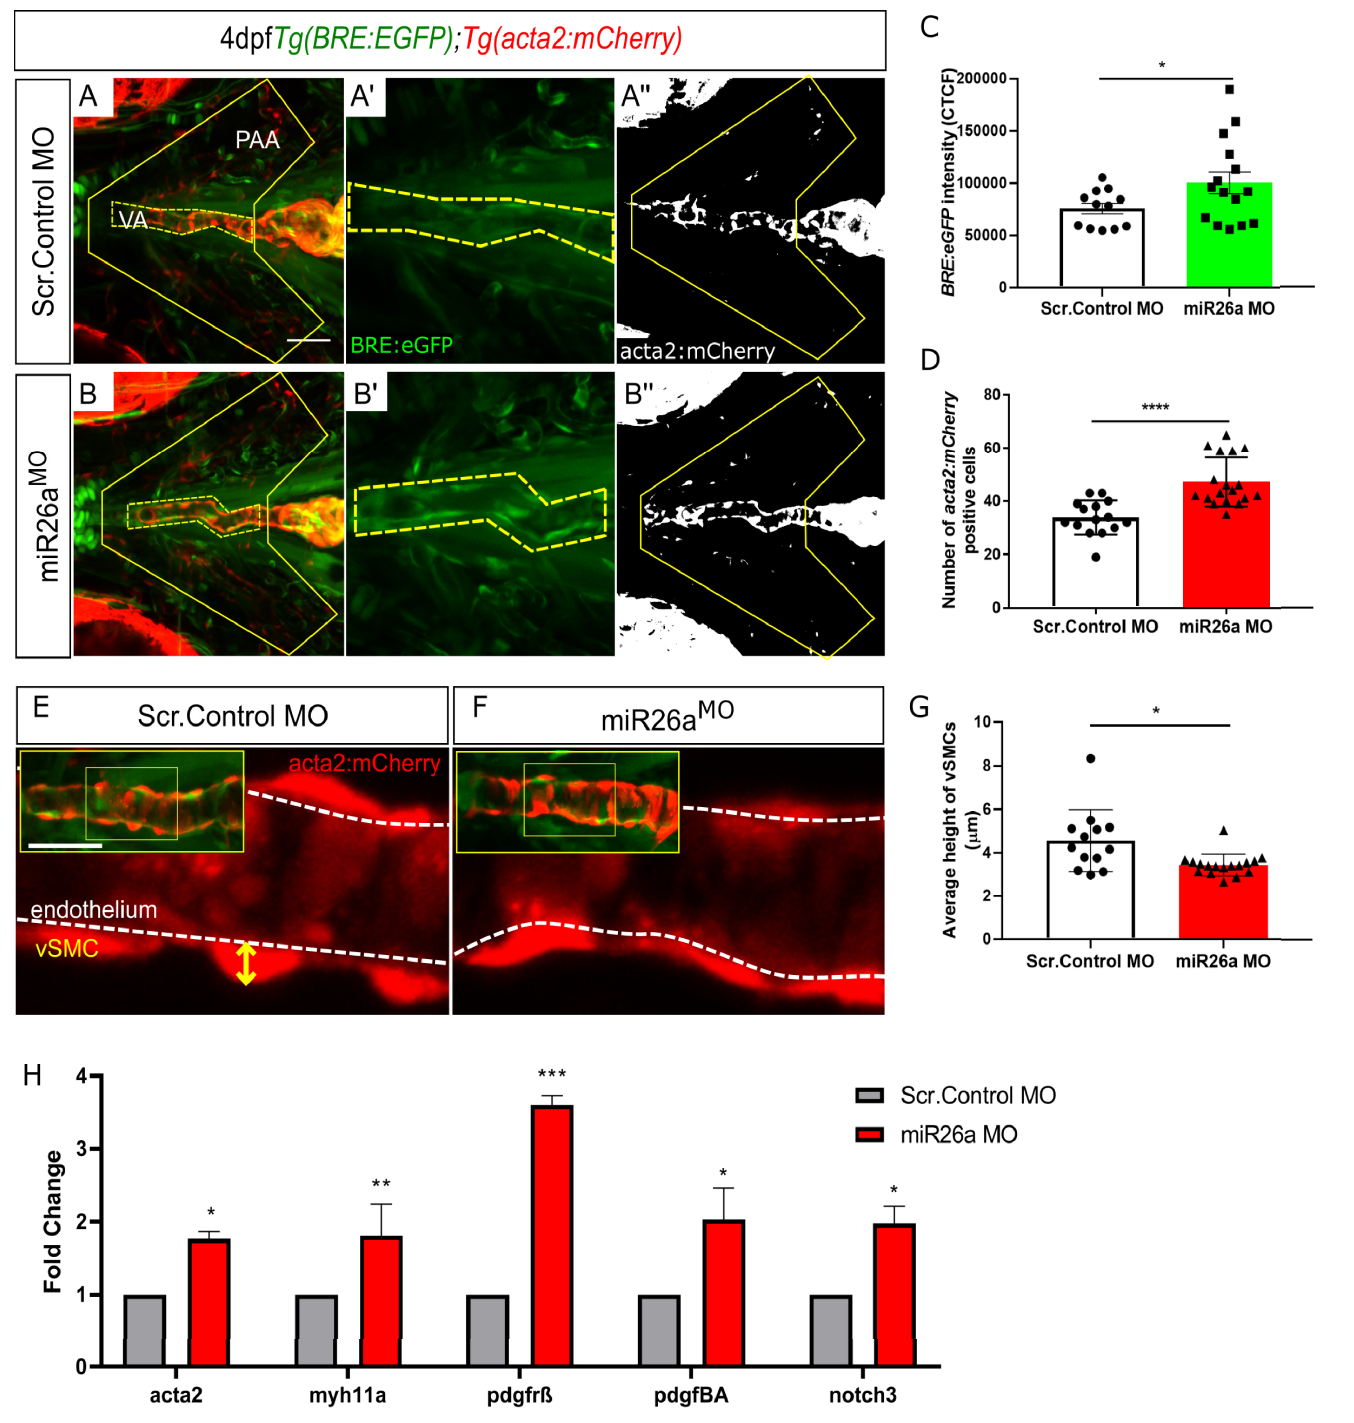
Fig 5. Loss of miR26a morphants leads to increased expression of vSMC genes and acta2 -positive vSMCs. A-B) Representative ventral views of 4 dpf Tg(BRE : EGFP); Tg(acta2 : mCherry) embryos. Scr. Control embryos (A-A”) and miR26a morphant embryos (B-B”) showing qualitative upregulation of BRE : EGFP in the ventral aorta (VA) and pharyngeal arch arteries (PAA). C) Quantification of green fluorescent marker ( BRE : EGFP ) along the VA, taken from the highlighted yellow region in A’ and B’, and represented as corrected total cell fluorescence (CTCF) (N = 3, miR26a MO n = 15, Scr. Control n = 12, Unpaired t test, ���� p < 0.0001 as compared to control, error bars = SEM). D) Quantification of acta2 positive cell number on VA and PAAs, within area outlined in A” and B”. Number of acta2 positive cells is significantly increased in miR26a morphants (N = 3, miR26a MO n = 18, Scr. Control n = 15, Unpaired t test, ���� p < 0.0001 as compared to control, error bars = SEM). E and F) Measurement